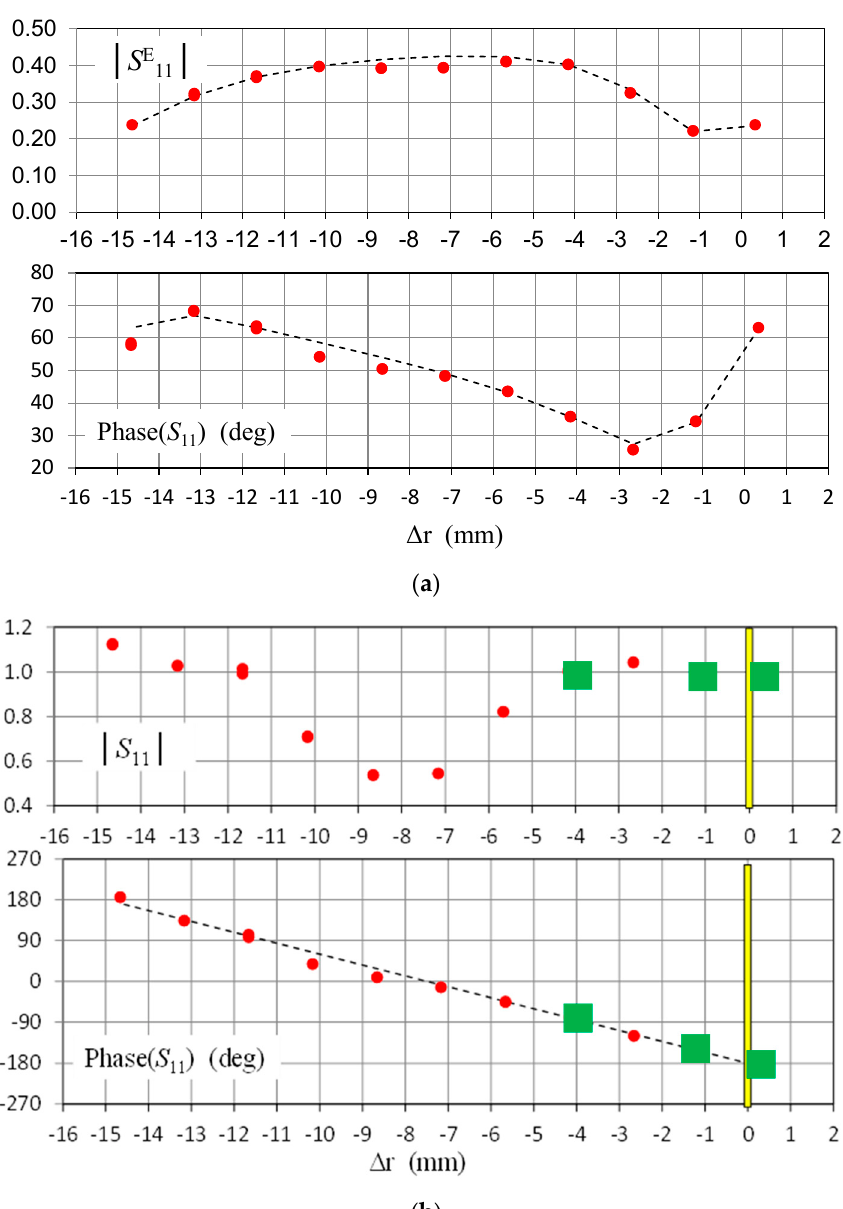
Figure 6. ( a ) Comparison between Modelled (—) and measured ( • ) empty free-space complex reflection S E as a function of the stand-off distance ∆ r from the reference plane (L r = 24.04 mm) 11 – f = 10 GHz. ( b ) Comparison between Modelled (—) and measured ( • ) calibrated empty free- space complex reflection S as a function of the stand-off distance ∆ r from the reference plane 11 (L r = 24.04 mm)—f = 10 GHz. The reference plane is illustrated in yellow color (at ∆ r = 0) and the calibration standards are illustrated with .